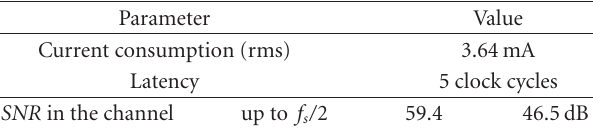
Table 4: Prelayout specifications for the